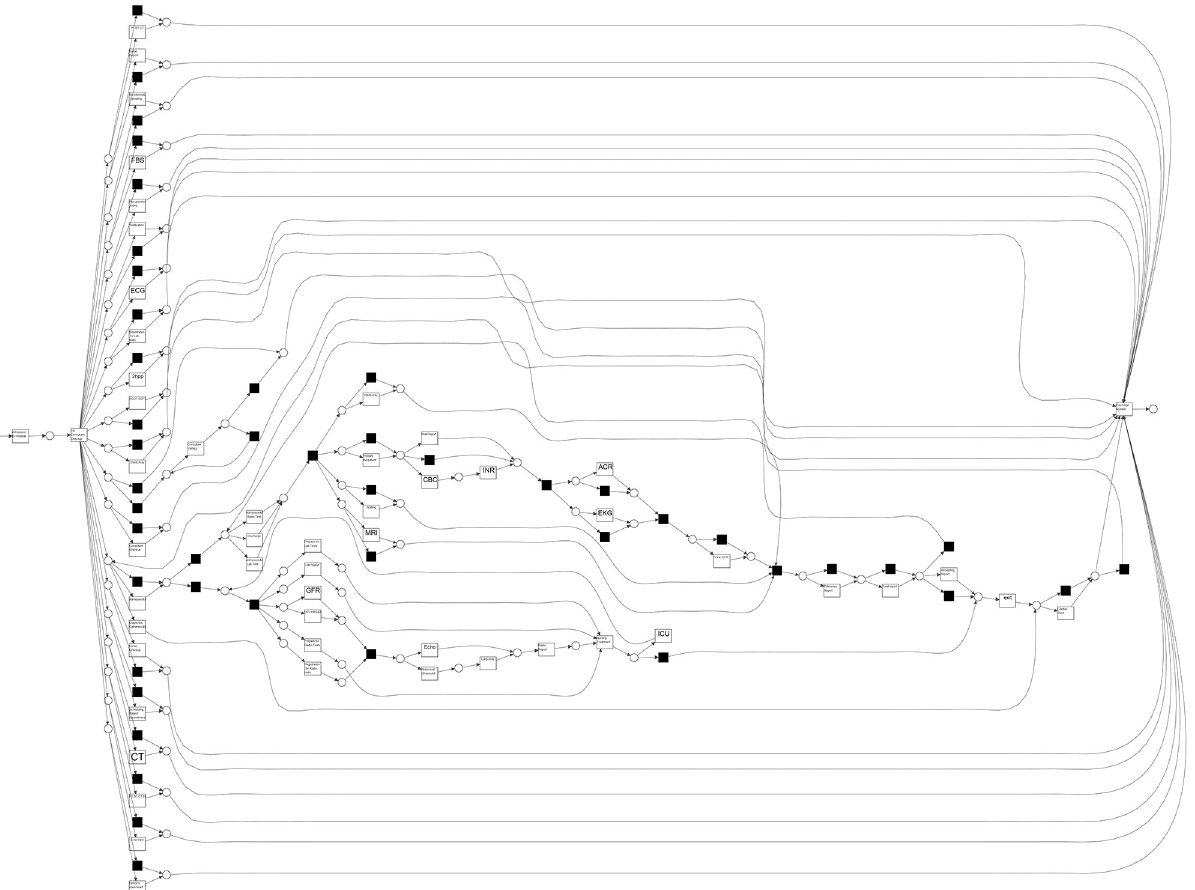
Fig 3. The first discovered process (A spaghetti model) using every